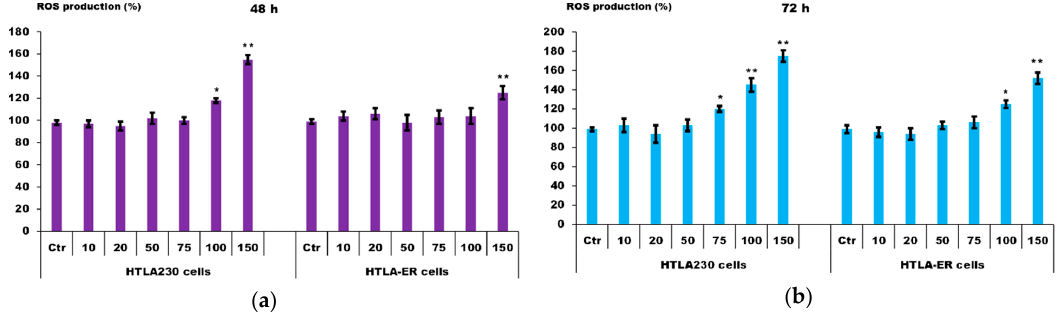
Figure 10. Time course of ROS levels in HTLA-230 and HTLA-ER cells treated with GA. ROS generation was analyzed in HTLA-230 and HTLA-ER cells exposed to GA (10–150 µM) for: 48 h ( a ); and 72 h ( b ). Histograms summarize quantitative data of the means ± S.E.M. of three independent experiments. * p < 0.05 vs. Ctr cells; ** p < 0.01 vs. Ctr cells.